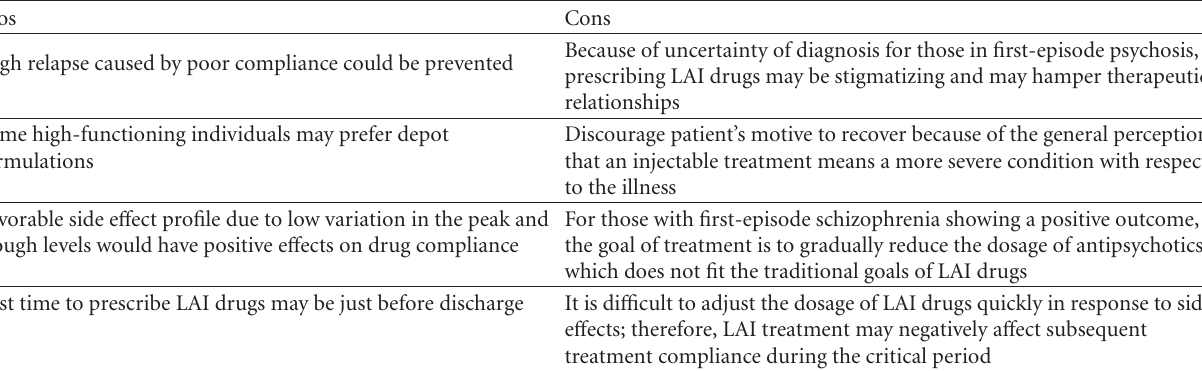
Table 2: The pros and the cons of using long-acting injectable (LAI) antipsychotics for the treatment of first-episode schizophrenia. Pros